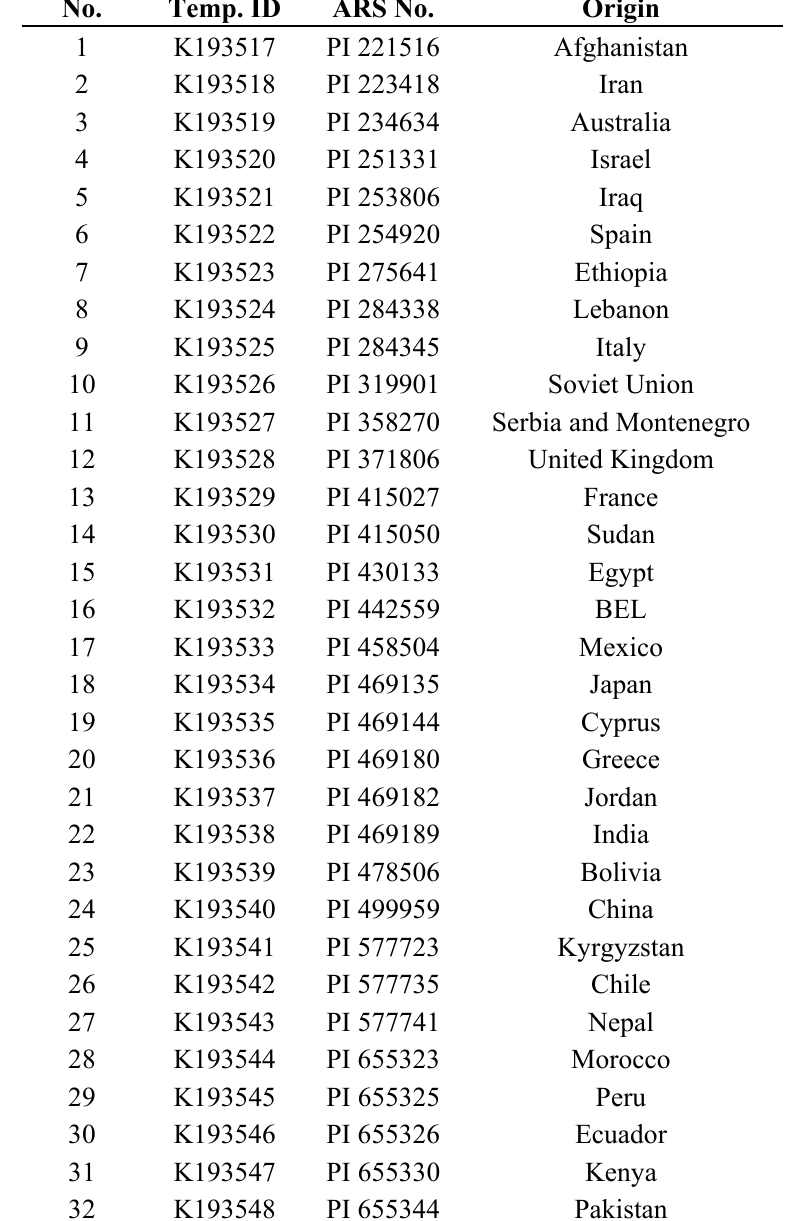
Table 3. List of faba bean ( Vicia faba L.) accessions and details of collection